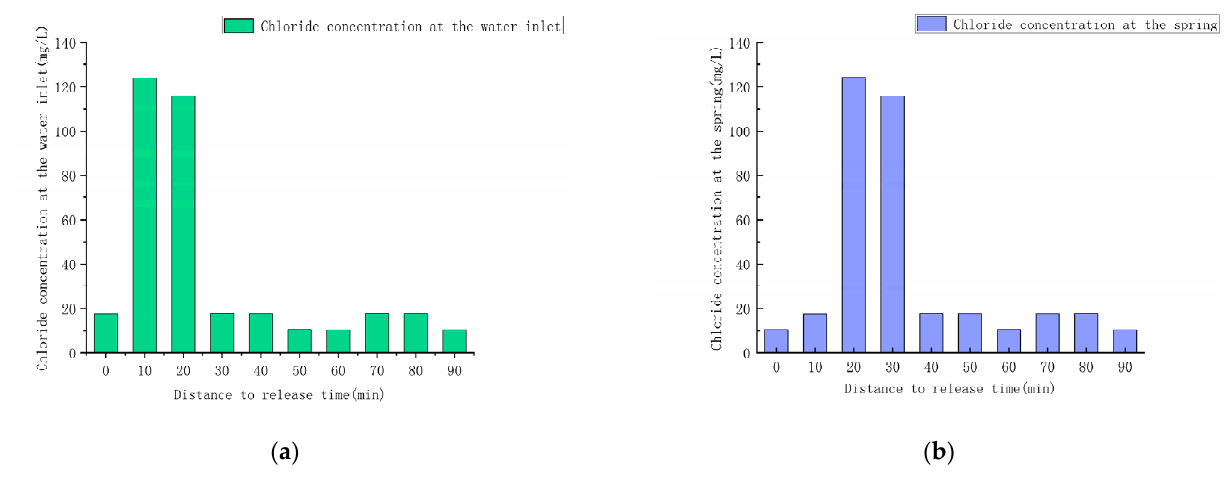
Figure 5. Tracer test results: ( a ) the first set of results; ( b ) the second set of results.